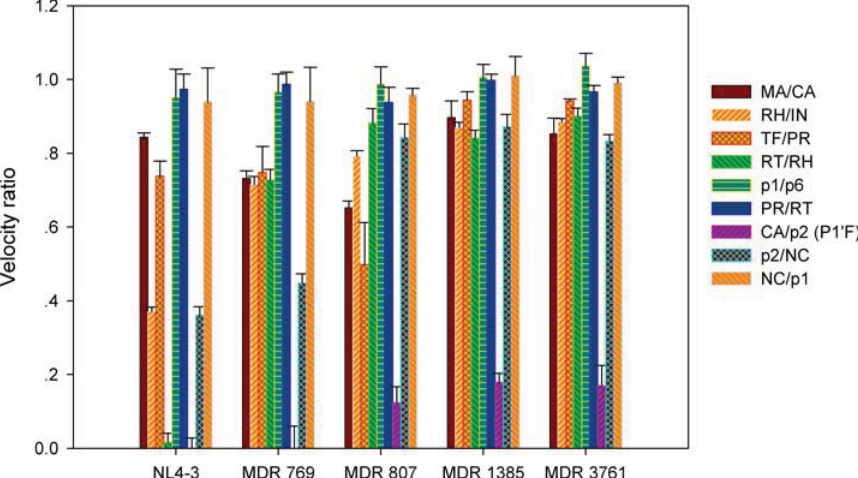
Figure 1. Förster resonance energy transfer substrate processing ratio. The bar chart represents the ratio of the average FRET substrate cleavage velocity in the presence of the regular peptide substrate over the average FRET substrate cleavage velocity in the absence of the regular peptide substrate. When the velocity ratio is one, the regular peptide does not affect the FRET substrate cleavage by the protease. When the velocity ratio is zero, the FRET substrate is completely competed out by the regular